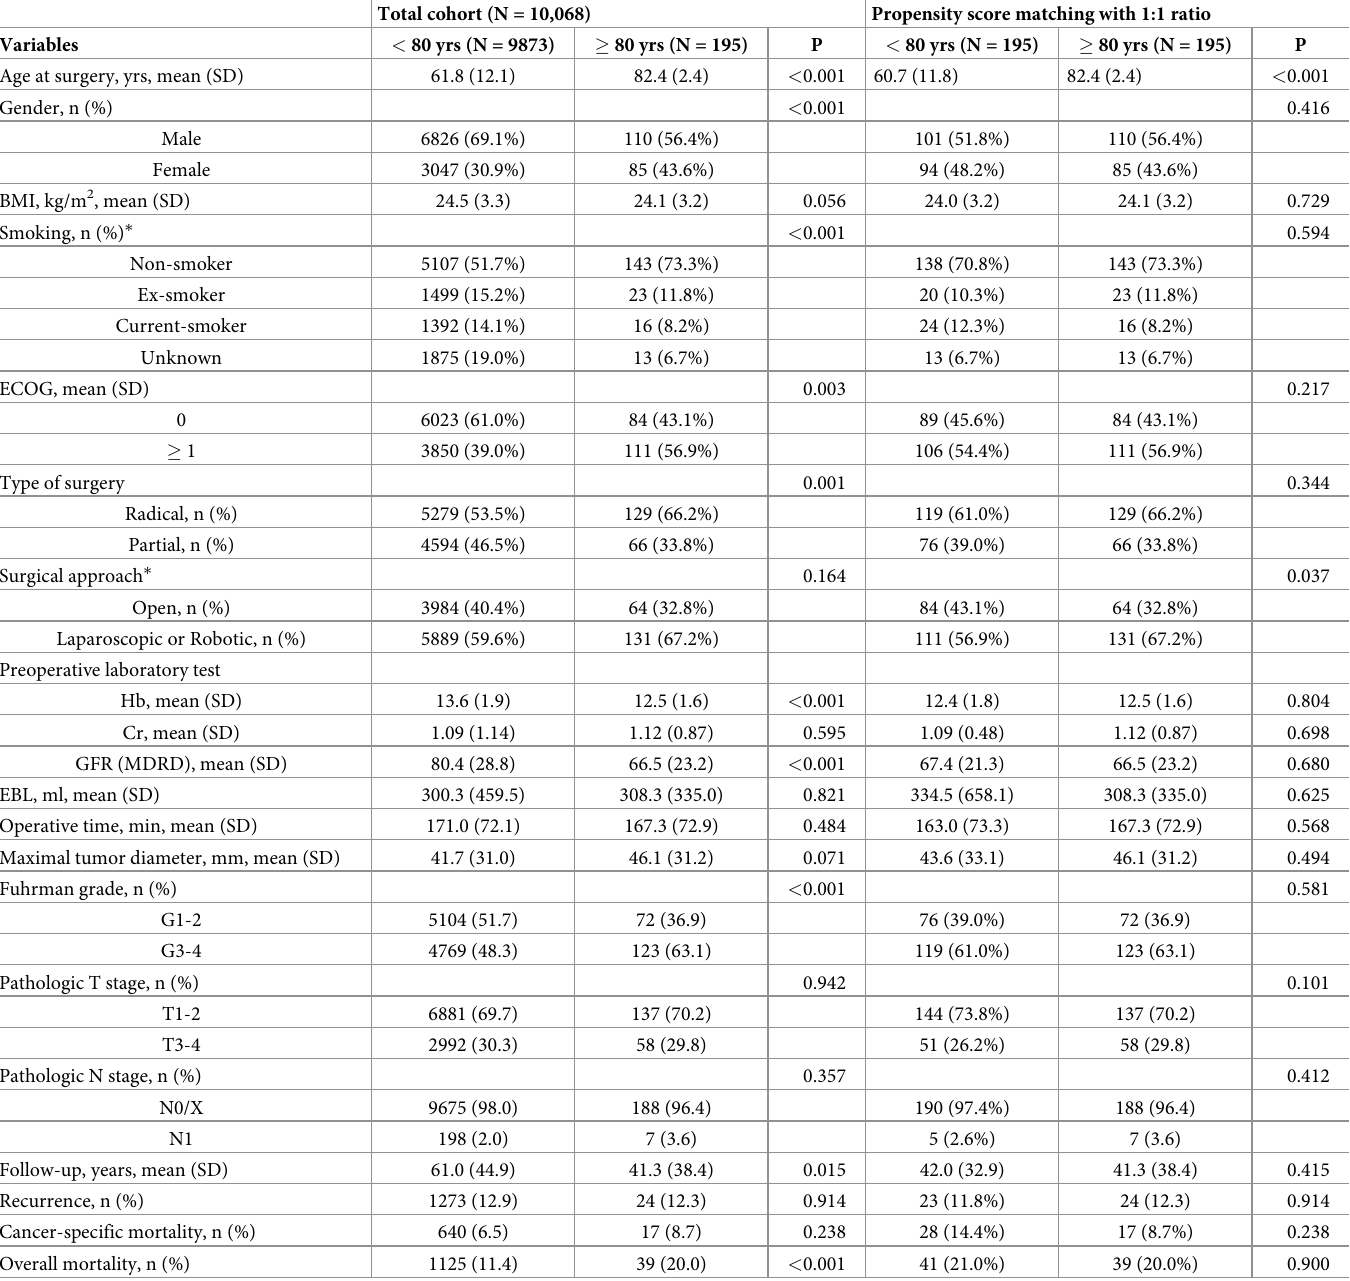
Table 1. Baseline